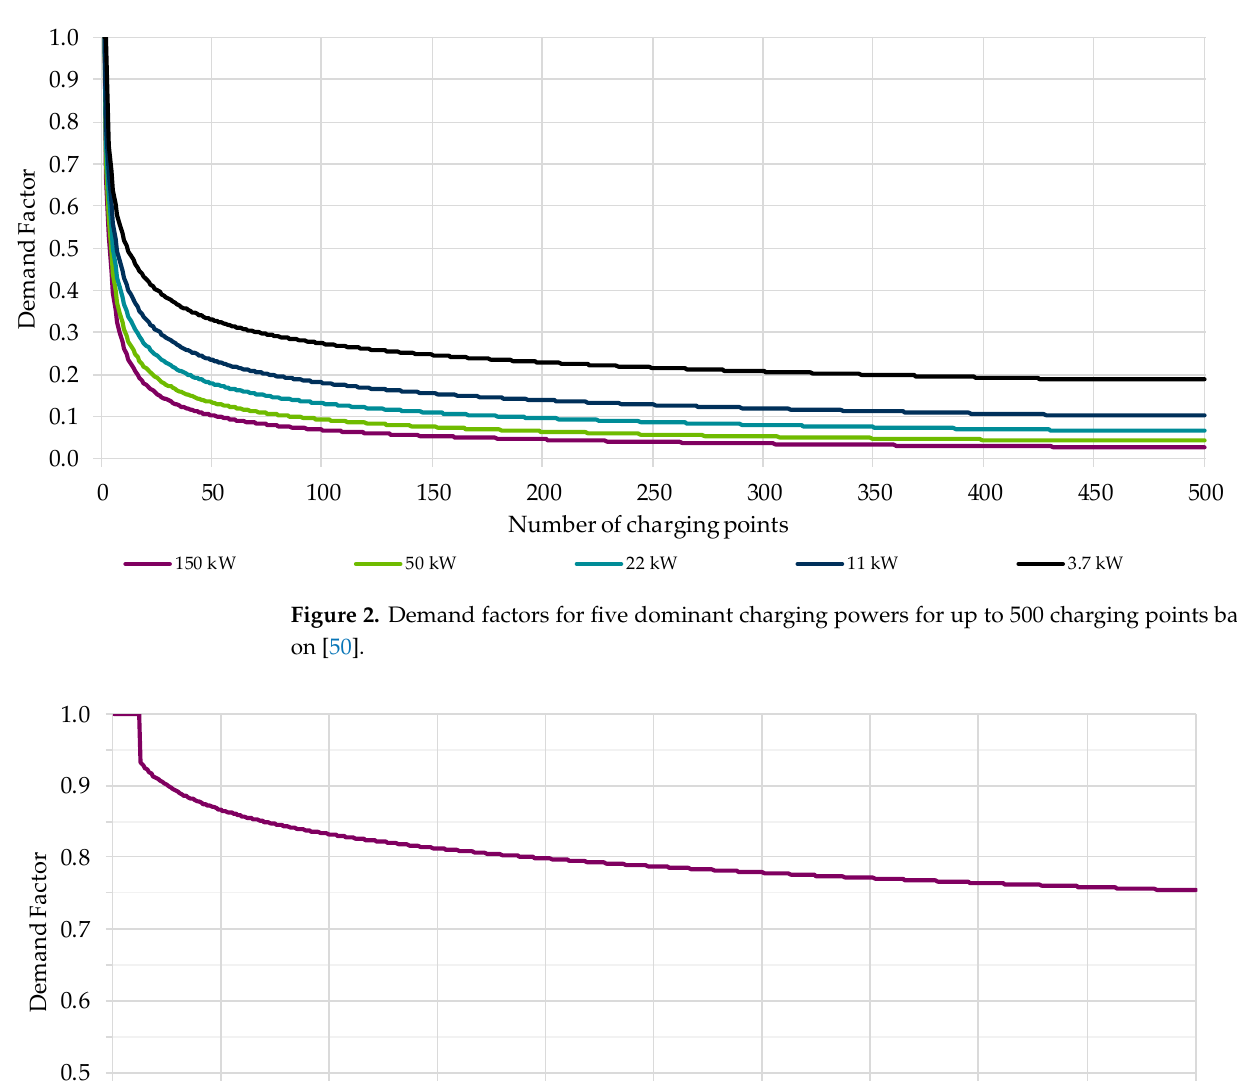
Figure 3. Demand factors for up to 500 heat pumps based on [51].